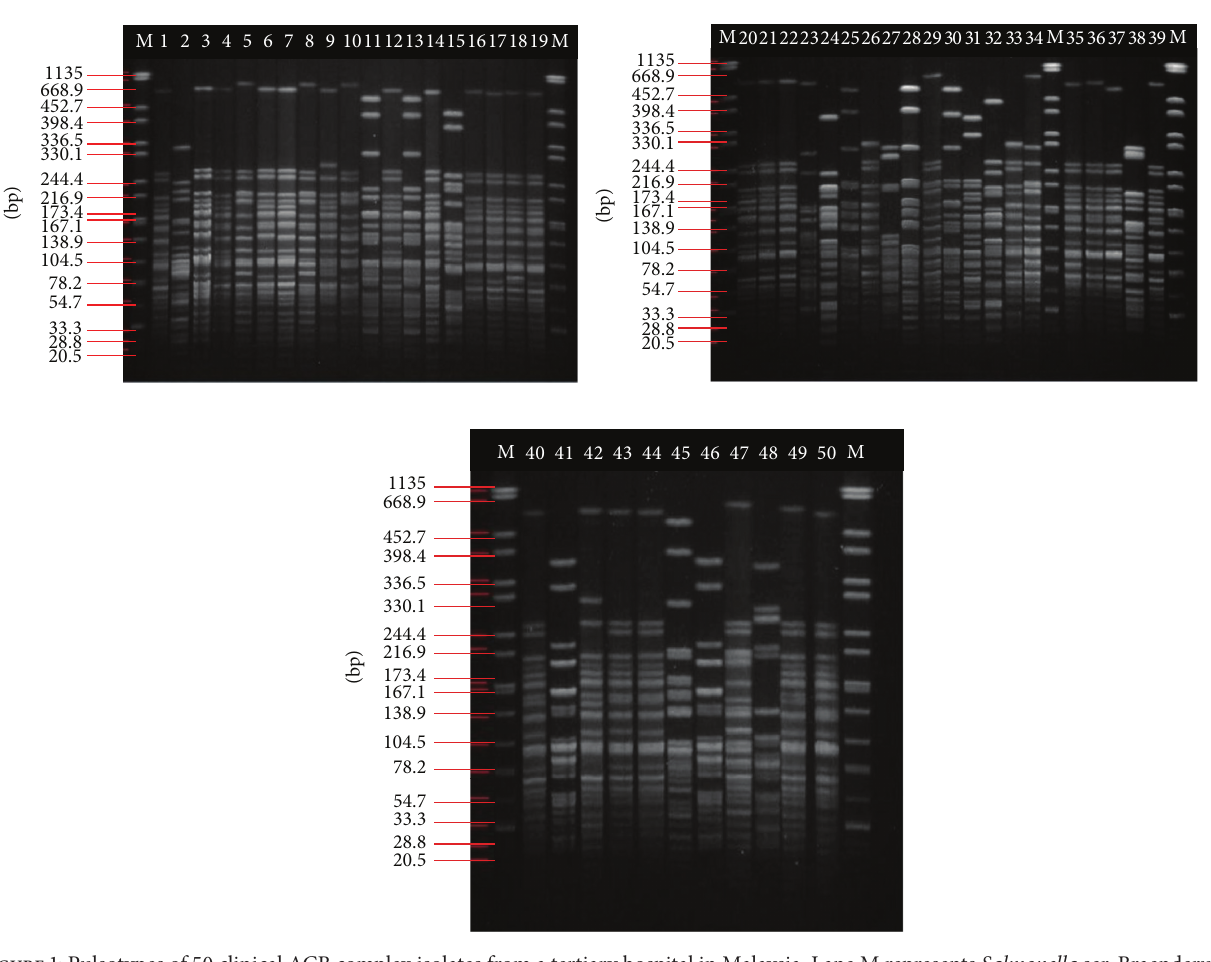
Figure 1: Pulsotypes of 50 clinical ACB complex isolates from a tertiary hospital in Malaysia. Lane M represents Salmonella ser. Braenderup H9812 as the marker. Lanes 1–50 represent clinical isolates